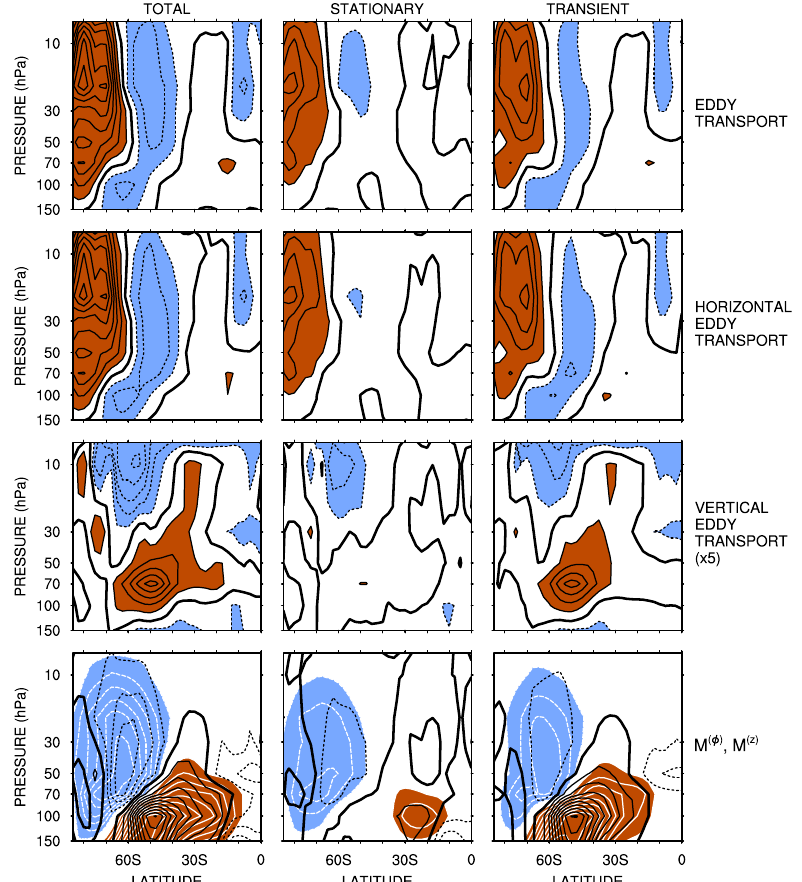
Fig. 4. Same as Fig. 2 but for the eddy ozone transport, its horizontal and vertical components, and the eddy flux vector, with the con- tributions of stationary and transient waves. Blue (brown) colors with dashed (solid) white lines represent negative (positive) values for M (φ) . Dashed (solid) black lines represent negative (positive) values while the bold solid line represents the zero-line for M (z) . Con- tour spacing is 5ppbvday − 1 for the eddy transport and its horizontal and vertical components, 2 × 10 5 kgppbvm − 2 day − 1 for M (φ) and 2 × 10 2 kgppbvm − 2 day − 1 for M (z) . Note that the vertical eddy transport is weak compared to the horizontal eddy transport and is therefore multiplied by